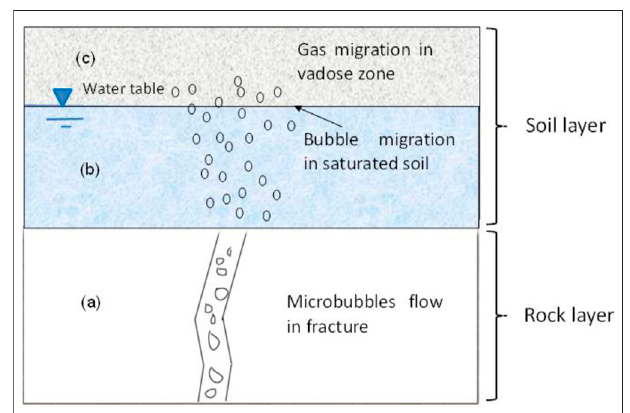
FIGURE 1 | Conceptual model of the gas movement in the studied subsurface environment: (A) microbubble fl ow in a fracture; (B) bubble fl ow in the saturated soil layer; the microbubbles become more dispersive in the soil layer, and (C) gas transport in the vadose